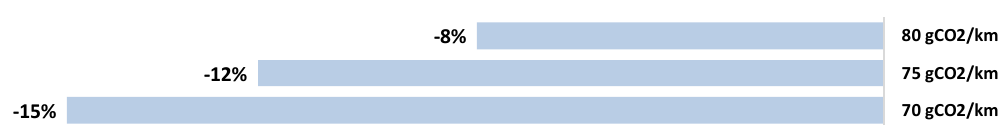
Figure 8. Evolution of CO 2 emissions in car transport by scenario in the EU.